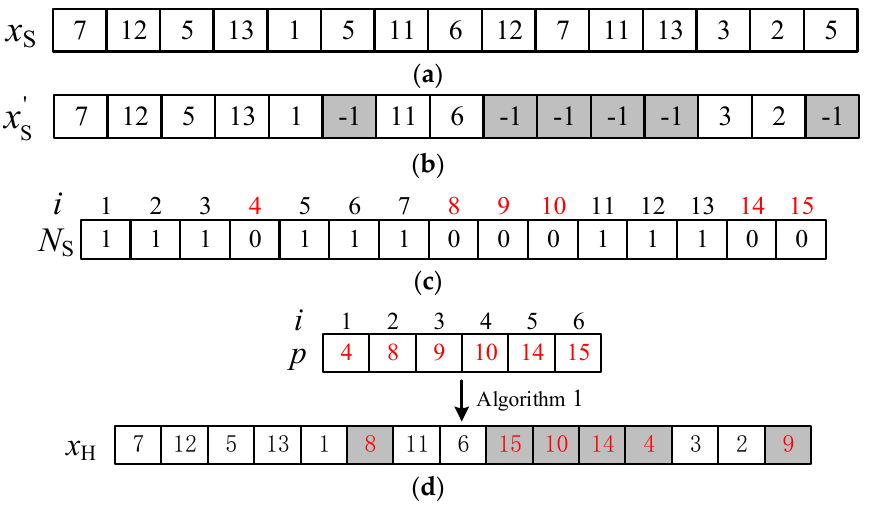
Figure 3. Hash table data structure.